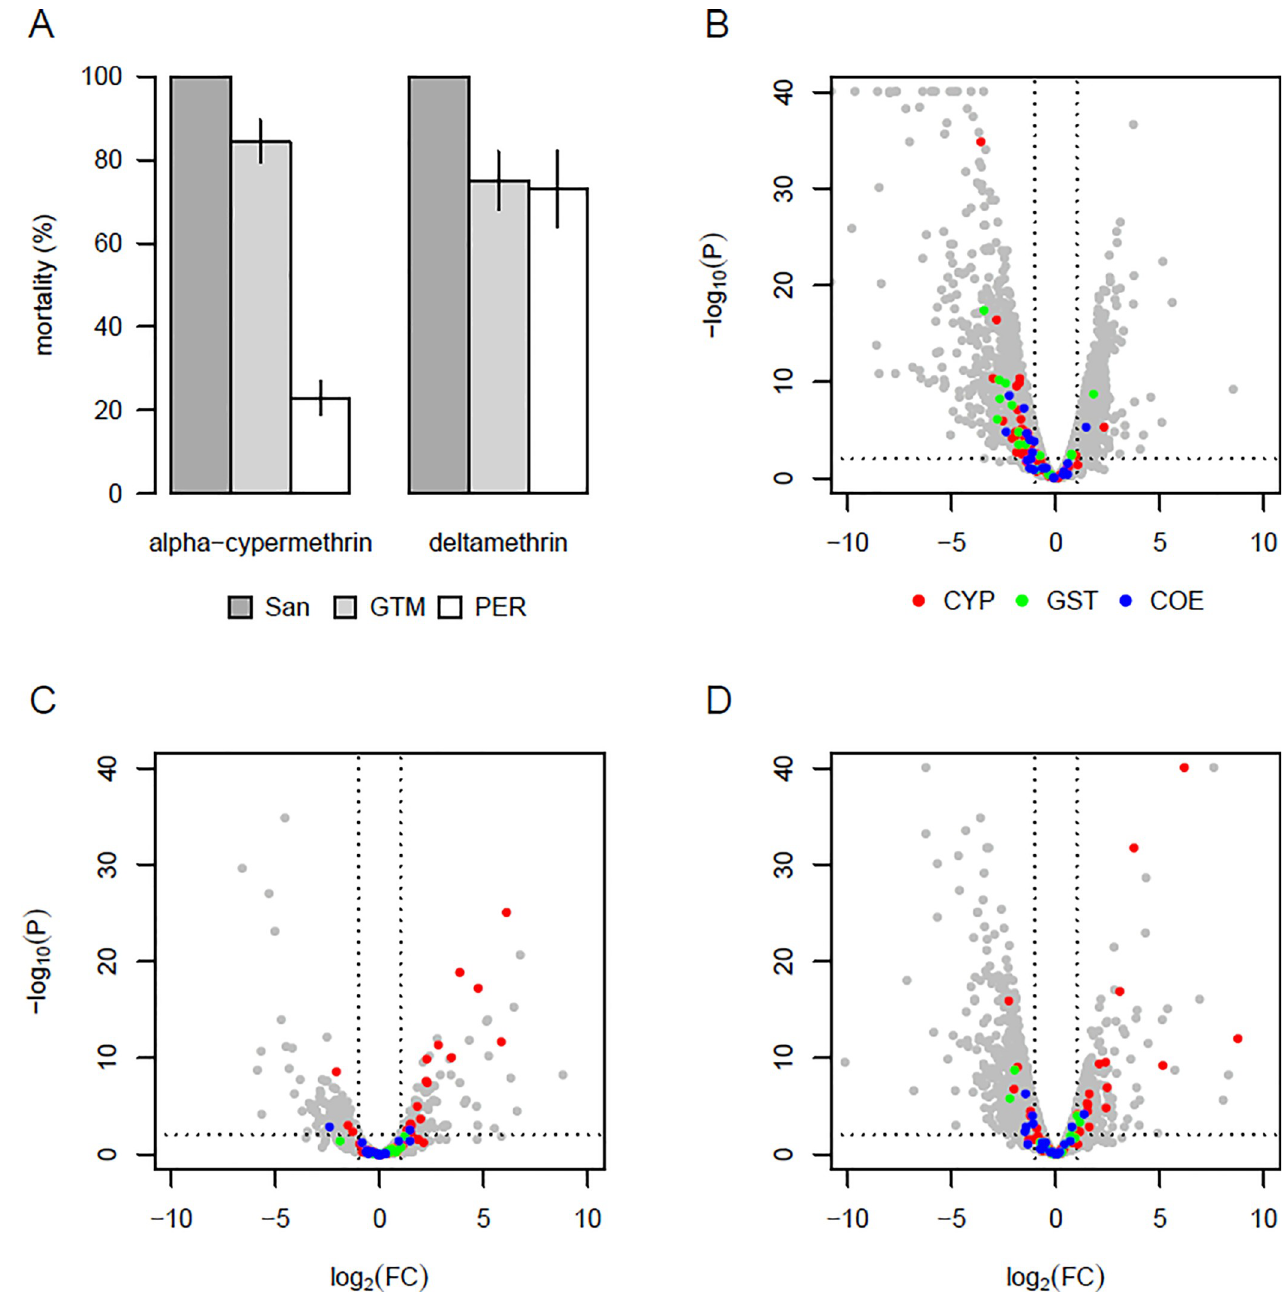
Fig 2. Pyrethroid resistance and gene expression profiles in An . albimanus . (A) Percent mortality in bottle bioassays for the susceptible Sanarate strain (dark grey) and field populations from Guatemala (light grey) and Peru (white). Bars show the means of 4 replicate assays, with error bars indicating +/-1 standard error of the mean. Remaining panels show volcano plots of gene expression for the comparisons: (B) Guatemala deltamethrin resistant vs . Sanarate; (C) Peru deltamethrin resistant vs . Sanarate; (D) Peru alpha-cypermethrin resistant vs . Sanarate. Red, green and blue points on the volcano plots indicate three gene families with major roles in metabolic resistance to insecticides: cytochrome P450 monooxygenases (CYP, red), glutathione S-transferases (GST, green) and carboxylesterases (COE, blue). In each plot, genes overexpressed in the population are > 0 on the x-axis. Vertical dotted lines indicate 2-fold expression differences and the horizontal dotted line indicates a p-value of